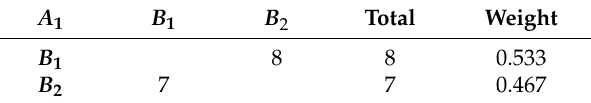
Table A8. Judgment matrix of B 1 – B 2 .